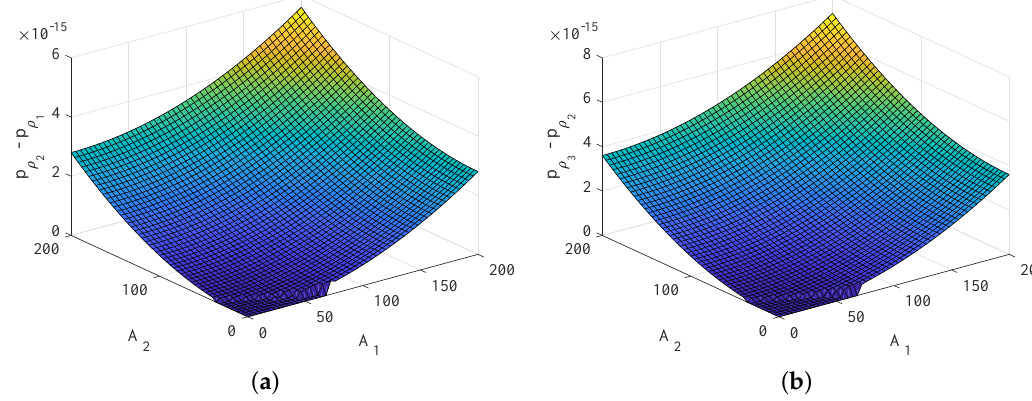
− p ρ − p ρ and ( b ) p ρ at the maturity 2 3 2 1